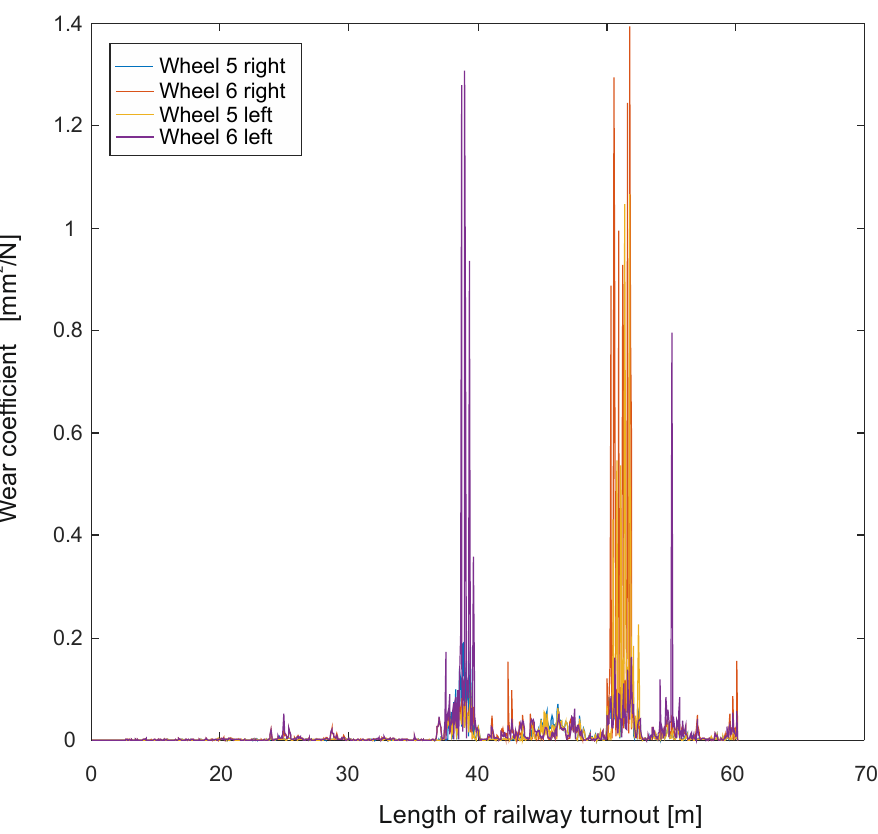
Figure 37. Wear coefficient obtained for a straight track without a turnout at 350 km/h. From the simulations presented, when passing through a turnout, the wear coefficients increase in the turnout entry area (needle and resistor) and in the crossover area. For traffic on a track without a turnout, the wear factors vary between 0.0005 and 0.05 N/mm 2 , while for traffic through a turnout, the factors vary between 0.16 and 12 N/mm 2 . In traffic on the track without a turnout, the maximum magnitudes come from the normal forces, which increase above the nominal force and decrease when the normal force decreases below the nominal force. The nominal force is 8.1 × 10 4 N. Simulations of 20,000 train runs on a straight track through a turnout at 200 km/h were performed. The wear results are shown for the left wheel of the wheelset and the wear of the rail by the left wheel. The wear of the left wheel is shown in Figure 38, and the wear of the rail is shown in Figure 39. The wears for the other wheels and rails are identical. For the same speed of 200 km/h, simulations were performed for wheel and rail wear when the rail vehicle moves on the track without turnout. Wheel wear is shown in Figure 40 and rail wear is shown in Figure 41 for the same